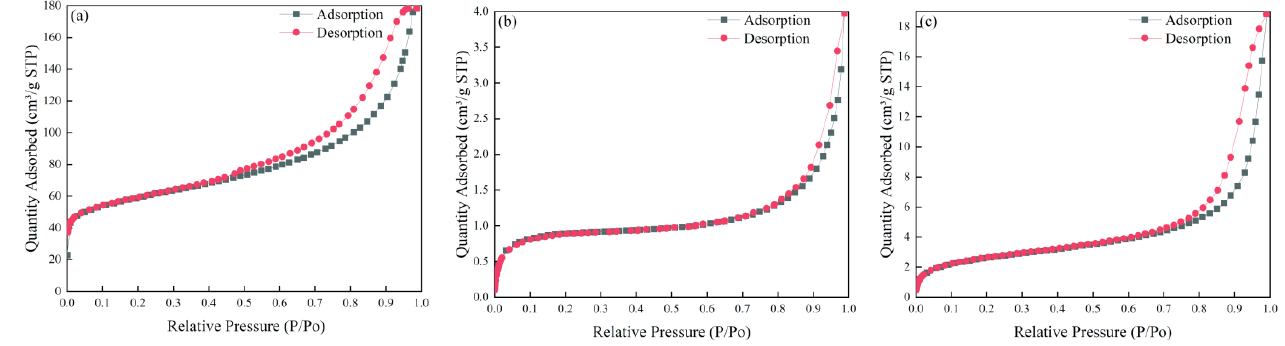
Figure 5. Brunauer – Emmett – Teller analysis of: ( a ) palygorskite, ( b ) modified palygorskite, and ( c ) EreB@modified palygorskite.